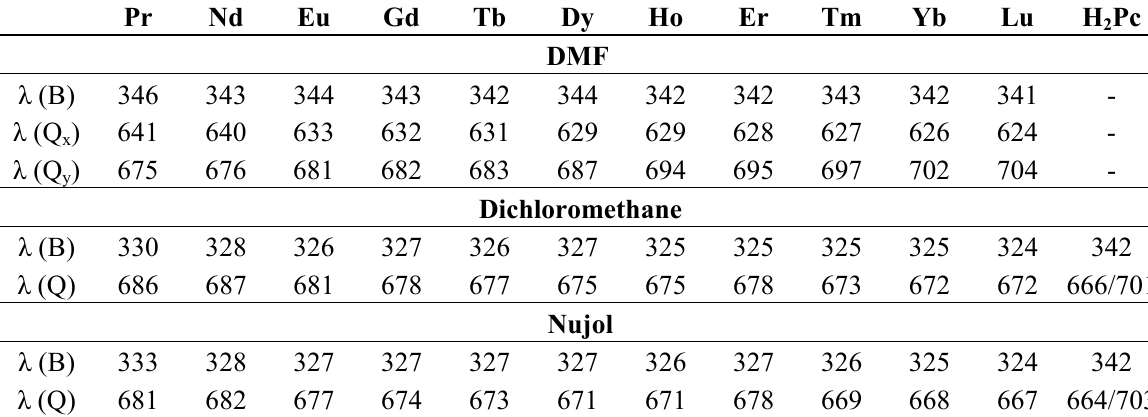
Table 2. Peak position of the B (Soret) and Q bands ( λ LnPc - R . Values of Q for Pr–Tb were determined using the Spectra Manager V.2 2 8 y analytical software.